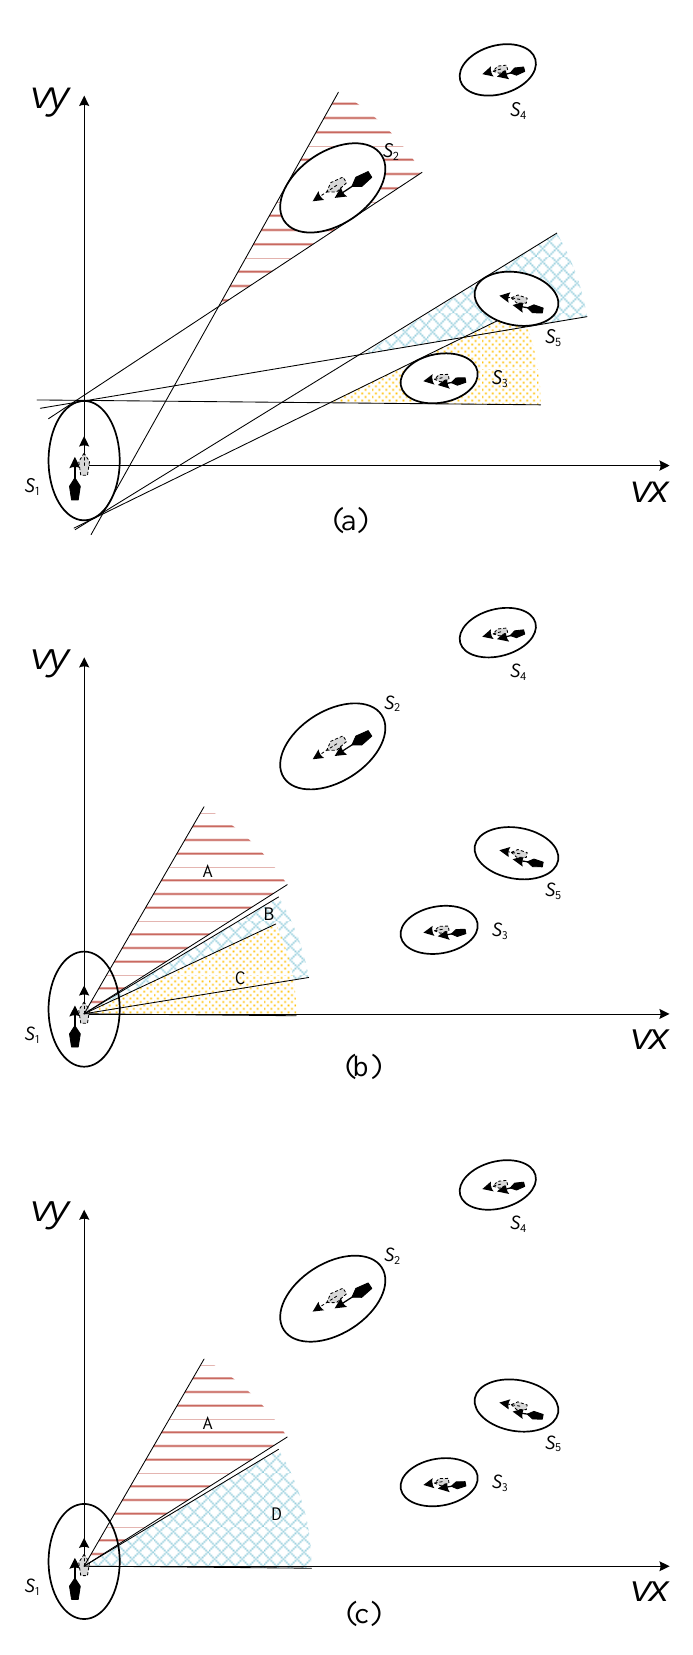
Figure 11. Combination of velocity obstacle cones: ( a ) determination of common tangents, ( b ) construction of VO cones, and ( c ) merging VO